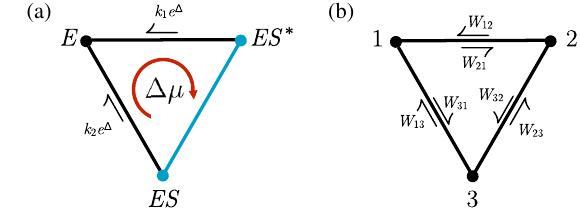
FIG. 15. (a) The transition graph G for the single-loop kinetic proofreading mechanism of Hopfield. The dissociation rates of the complexes ES (cid:4) and ES are the only rates that depend on the binding energy Δ . Perturbing Δ is equivalent to vertex and edge perturbations (blue). (b) State numbers and rate labels we use in this subsection. Key equivalences are 1 ¼ E , 3 ¼ ES , W k e Δ , and W k e Δ 12 ¼ 1 13 ¼ 2